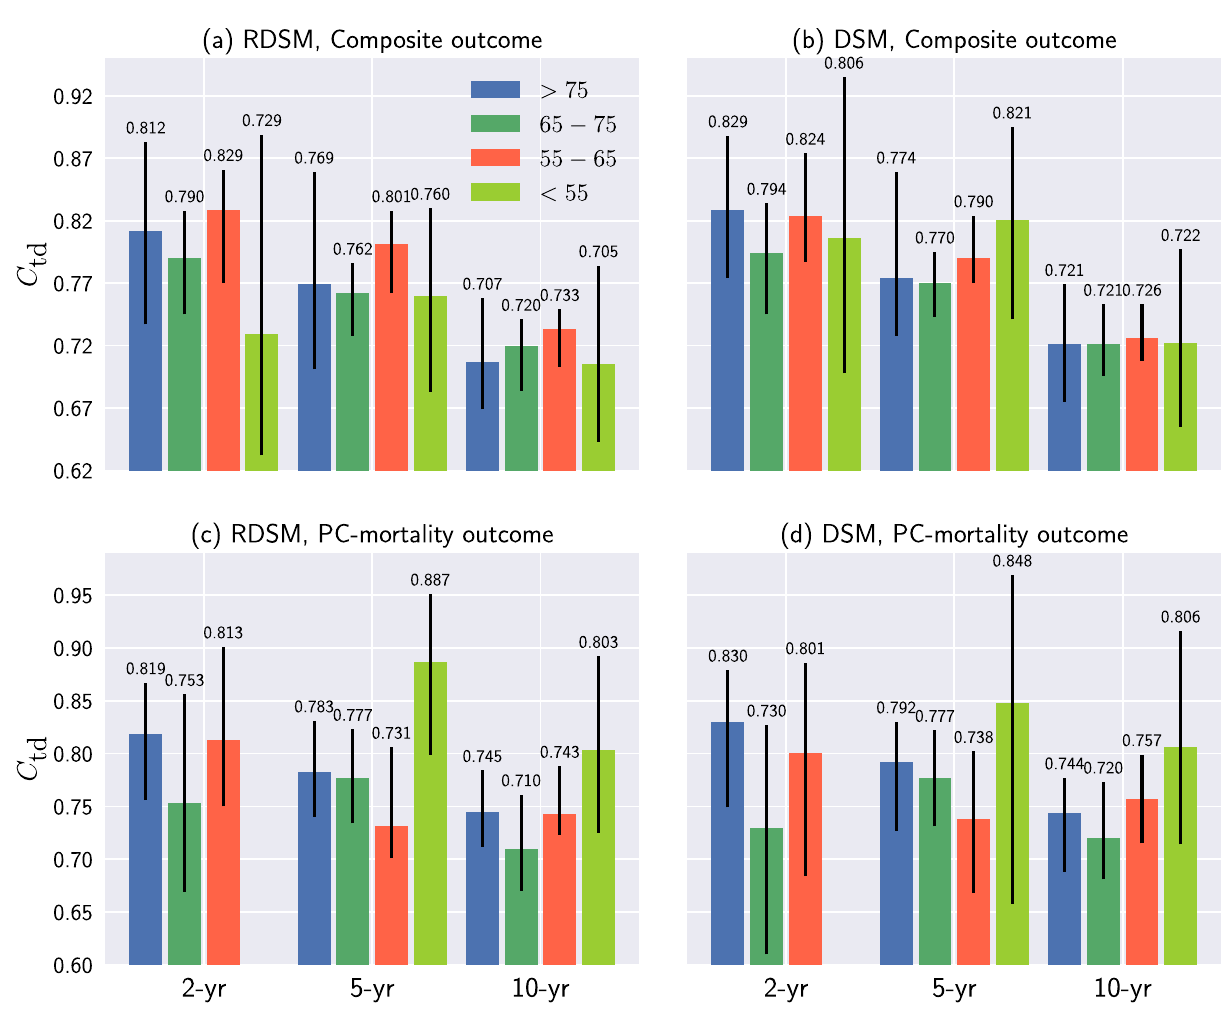
Figure 6. Age subgroup analysis for RDSM and DSM. Note that there is no incidence of PC-mortality in the < 55 age group. Black lines denote 95%